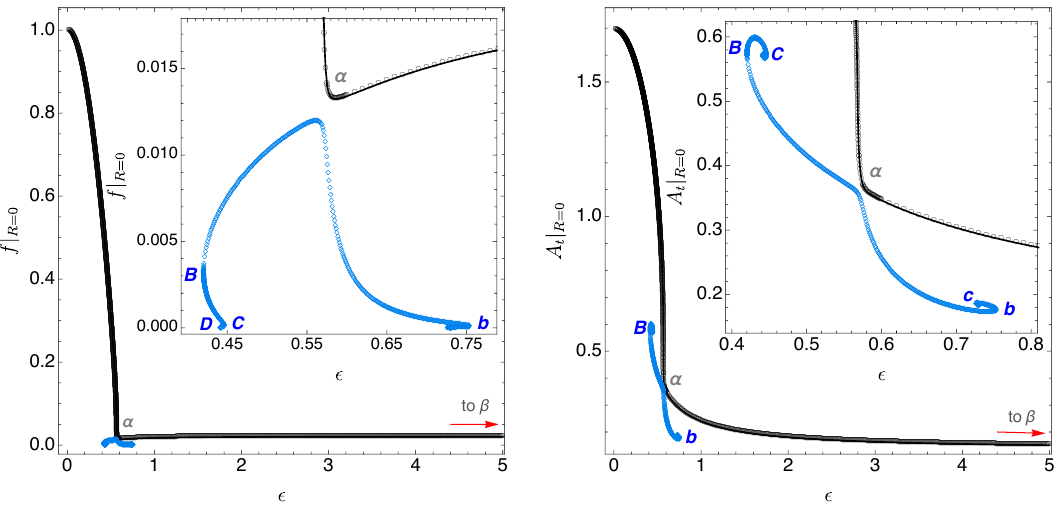
Figure 10 . Soliton families with e = 1 . 855 ( e c < e < e ). Comparing with the e . e c case of S figure 7 we identify main differences: the black curve is still the main soliton family but it now extends to arbitrarily large (cid:15) . On the other hand, the secondary soliton family — blue diamond curve — is now confined to a small window of scalar condensate amplitude (cid:15) . Note that as e → e + , c the gap between the two curves, in the region vaguely signalled as α , decreases until it vanishes precisely at e = e c . Left panel: f (0) as a function of the amplitude (cid:15) . Right panel: the gauge field evaluated at the origin A t (0) as a function of (cid:15) . This time the secondary family only exists for a small range of scalar field amplitudes and develops a ‘double-spiral’ structure, i.e. a cusp structure develops at either end of the curve, in the trenches Abc · · · and BCd · · ·